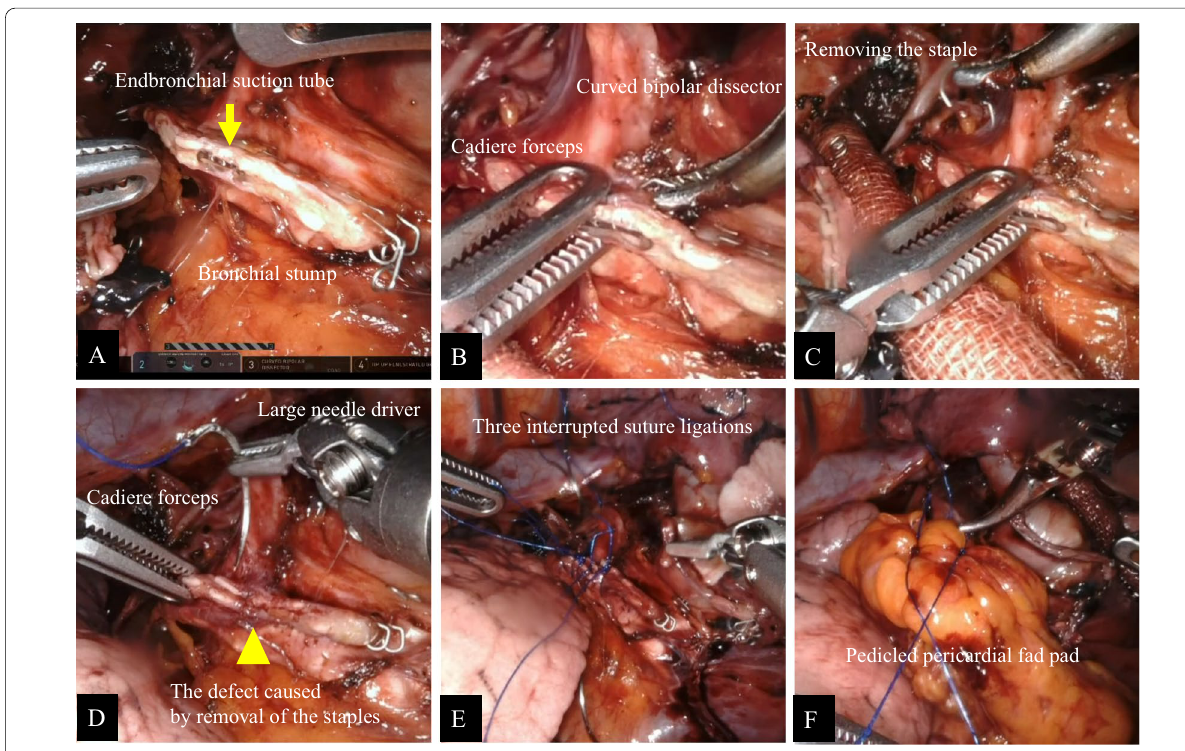
Fig. 2 Intraoperative views. A Endobronchial suction tube involving the dissected right lower lobe bronchus (arrow). B Curved bipolar dissector allowed the surgeon to pinch the staple individually while grasping the bronchus with cadiere forceps to prevent it from moving. C All the staples involved with the suction tube were successfully removed. D Primary closure of the defect in the bronchial stump caused by the removal of the staple (arrow head). E Three interrupted suture ligations were placed at the defect in the bronchial stump. F Covering the bronchial stump with